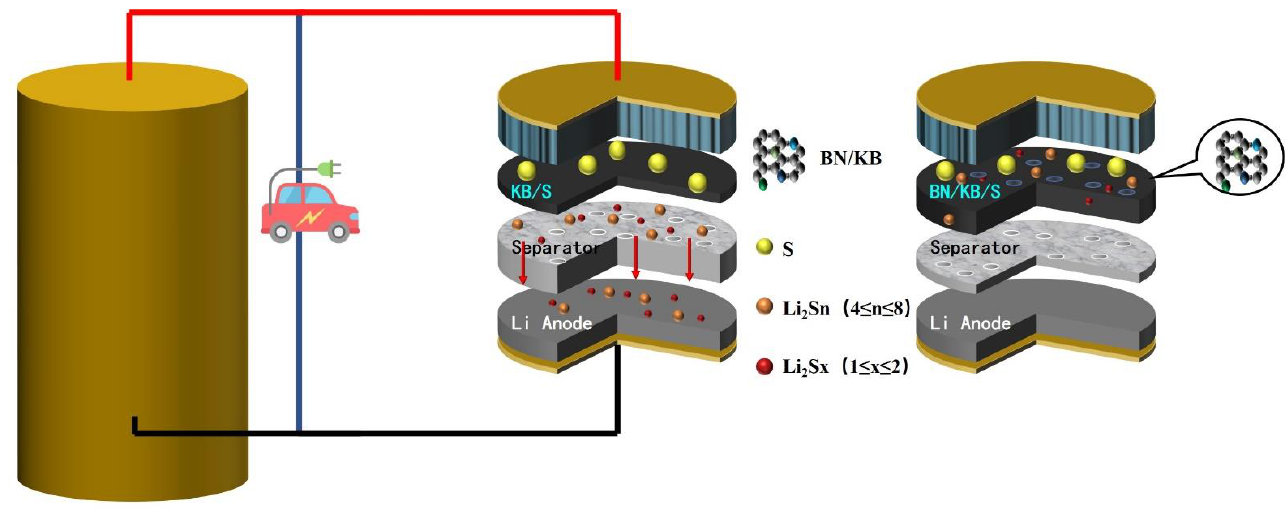
Figure 1. Schematic diagram of lithium–sulfur battery structure and modified structure.